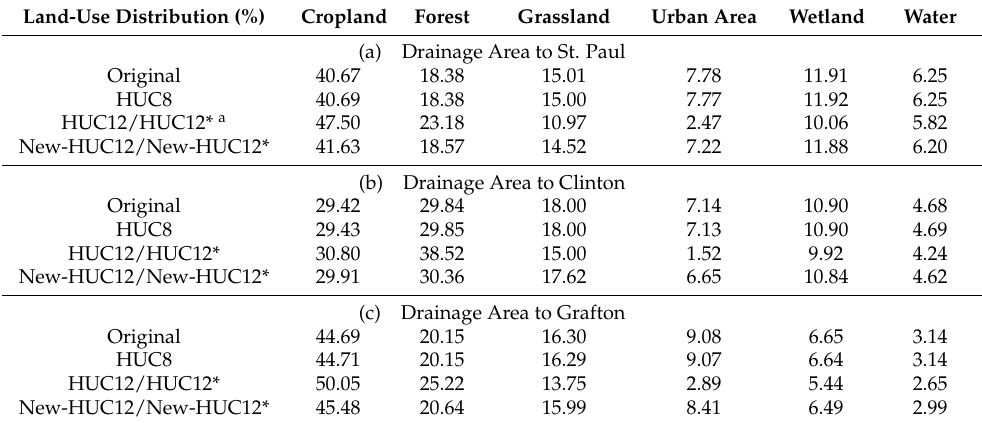
Table 3. Land-use distribution (%) in different delineation scenarios for the areas that drain to (a) St. Paul, (b) Clinton and (c) Grafton, respectively. The original scenario represents the baseline land-use distribution with 0%